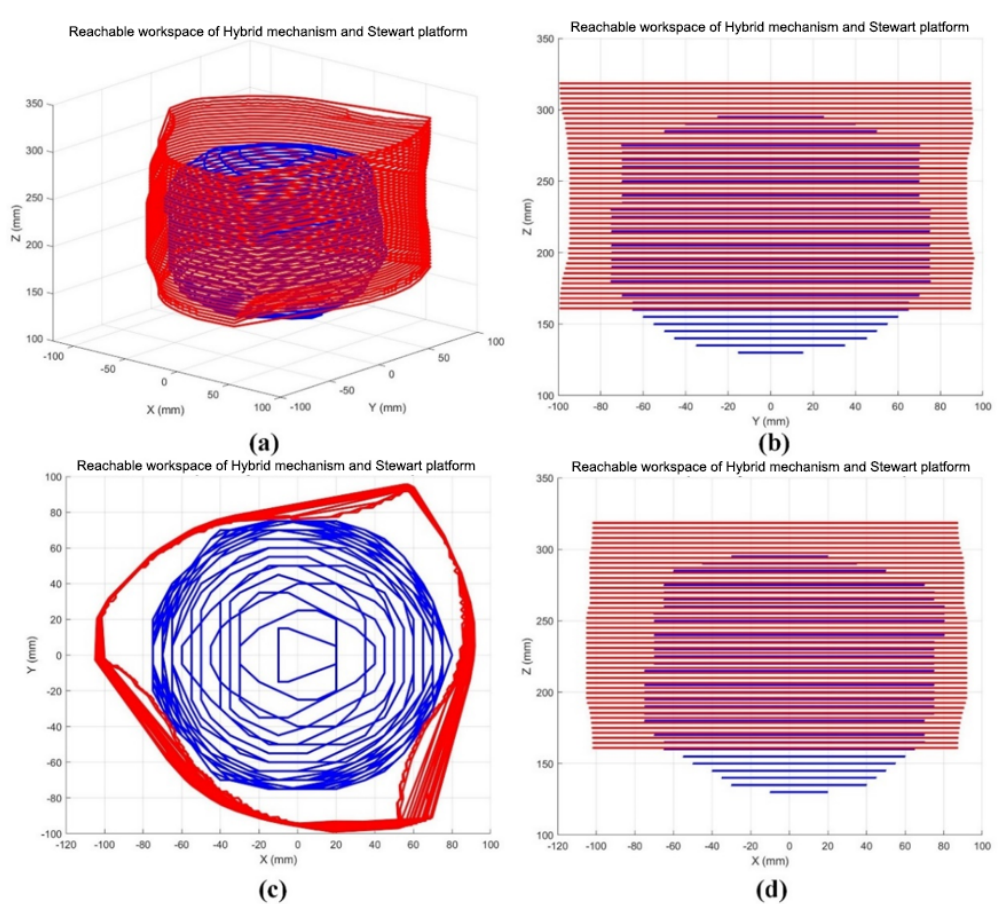
Figure 9. Linear workspace representation of the hybrid mechanism (red) and the Stewart platform (blue) in the ( x , y , z ) coordinate system.